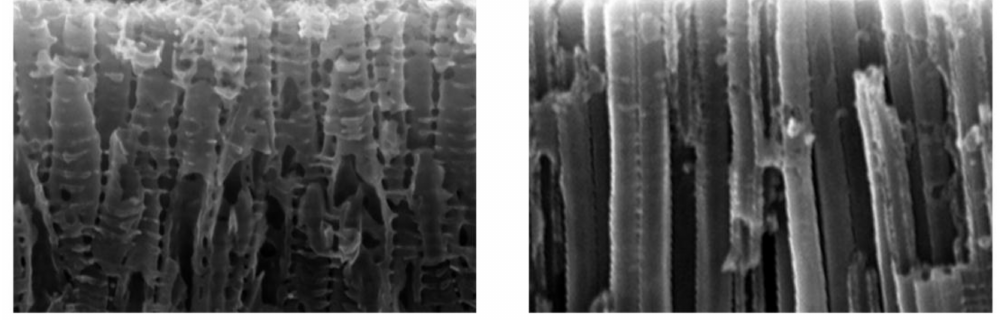
Figure 7. Schematic representation of nanotubes cross-section highlighting the tortuosity of